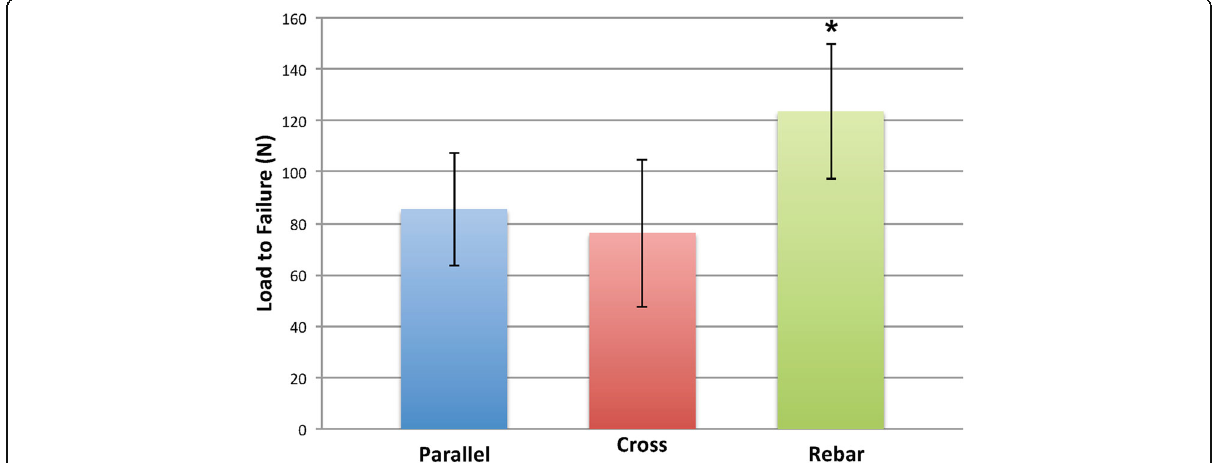
Fig. 4 Bar graph showing average load to failure values (N) for all three repair types with standard deviation error lines. * Load to failure was significantly higher for the Rebar Repair than the parallel and cross-stitch groups ( p <